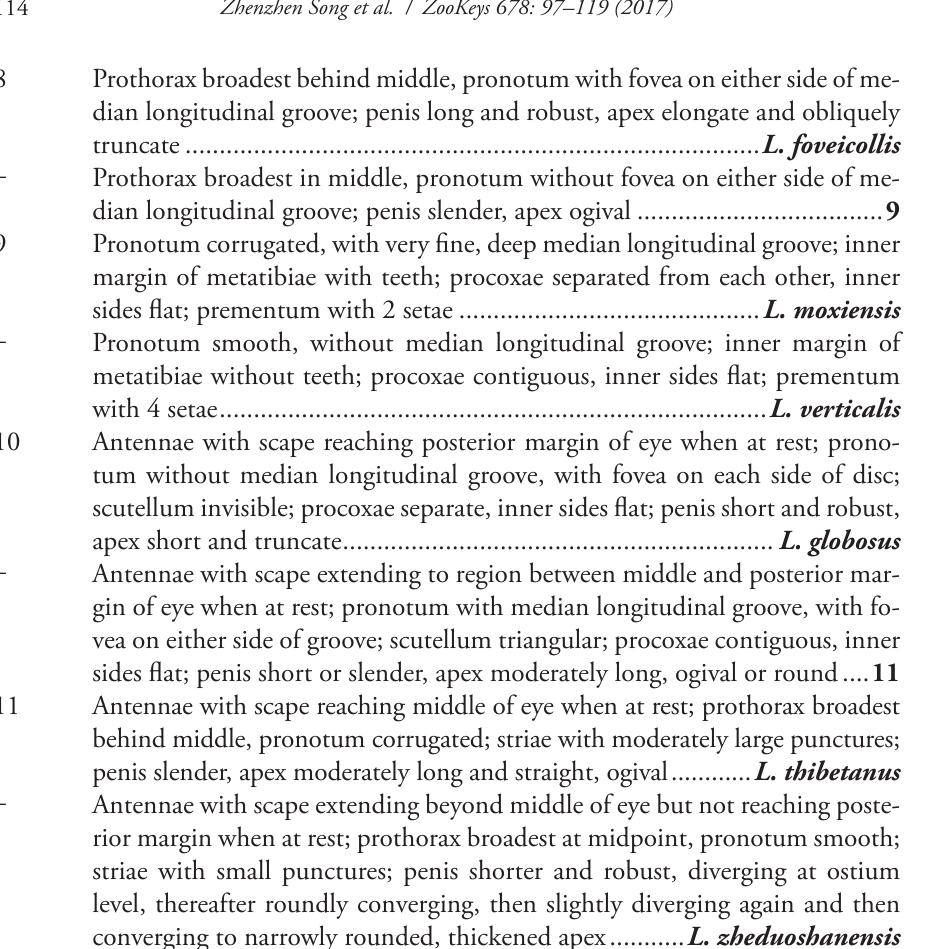
Geotragus granulatus (Chao, 1980), comb. n. Leptomias granulatus Chao, 1980. Entomotaxonomia 2(1): 29. Leptomias chenae Alonso-Zarazaga & Ren, 2013. Catalogue of Palaearctic Coleoptera 8: 89, 396 (replacement name for secondary homonymy). Comments. The correct name for this species under Geotragus is G. granulatus , not G. chenae , because of Art. 59.4 of the Code: “59.4. Reinstatement of junior secondary homo- nyms rejected after 1960. A species-group name rejected after 1960 on grounds of second- ary homonymy is to be reinstated as valid by an author who considers that the two species- group taxa in question are not congeneric, unless it is invalid for some other reason.” Redescription. Body medium-sized, black to reddish brown. Eyes lateral, oval, con- vex, with deep and fine circumferential stria. Rostrum 1.14× longer than wide, base narrower than frons, with slightly broad, deep median sulcus, reaching vertex.